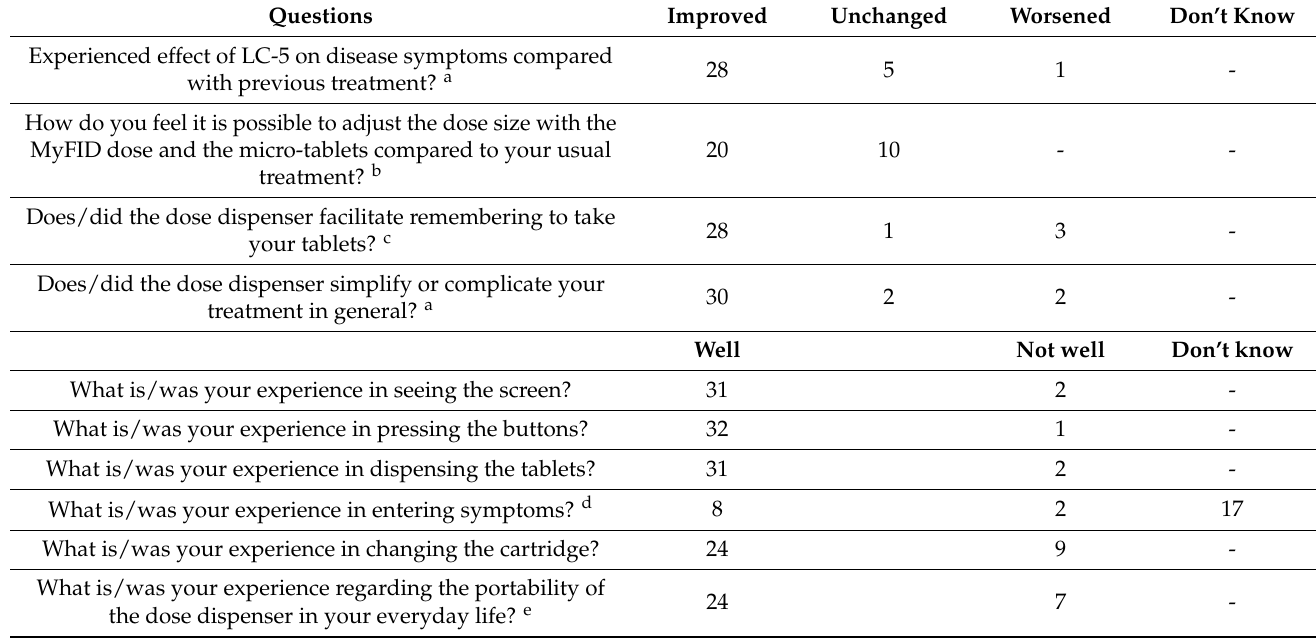
Table 3. Questions asked with answers ( n = 33 if not otherwise